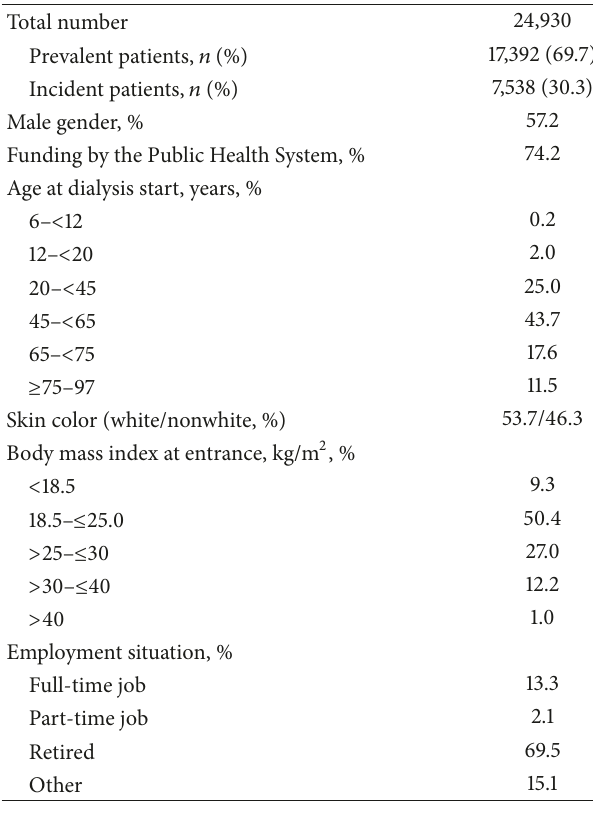
Table 1: General features of the program. Table 2: General characteristics of